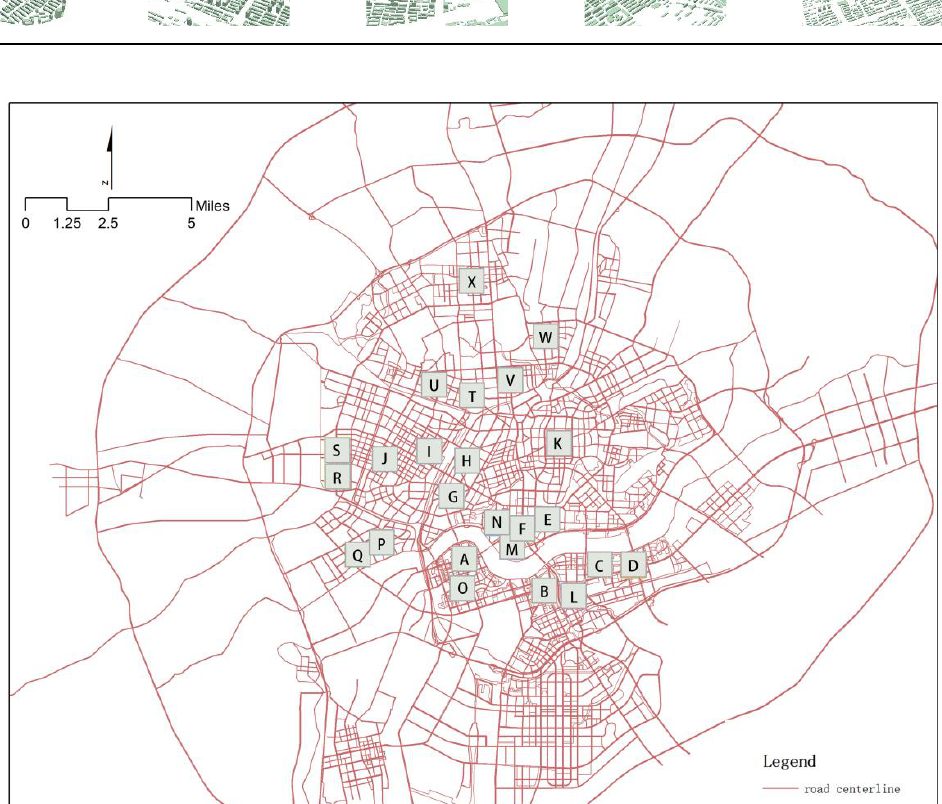
Table 2. Power law relationship between grid size r and 3D box height. Figure 2. Schematic diagram of the location of 24 research samples in the city. Prepared by the authors.